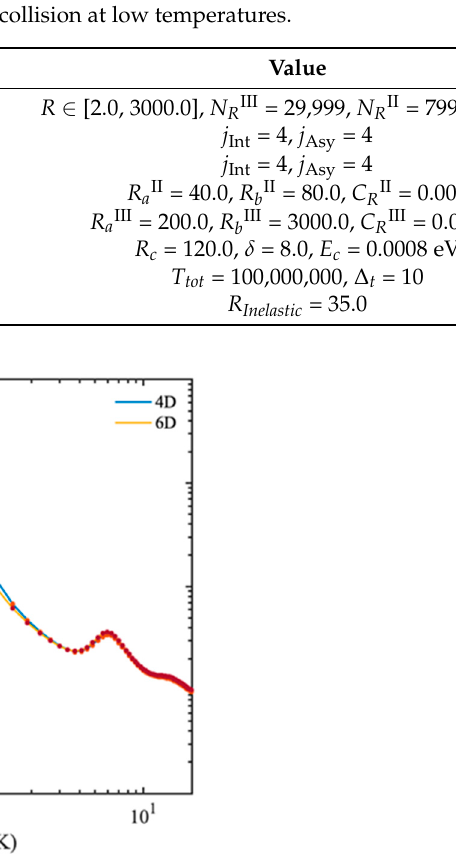
Table 3. Numerical parameters used in IALR-WP calculations for the HD( v = 0, j = 1) + H 2 ( v = 0,